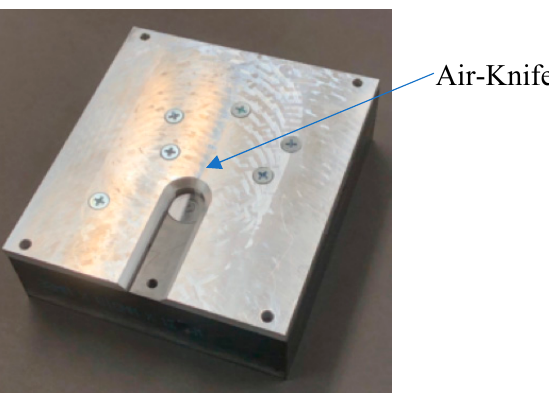
Figure 1. Camera housing design with cooling and integral air knife for keeping optics clean in high-dust environments.